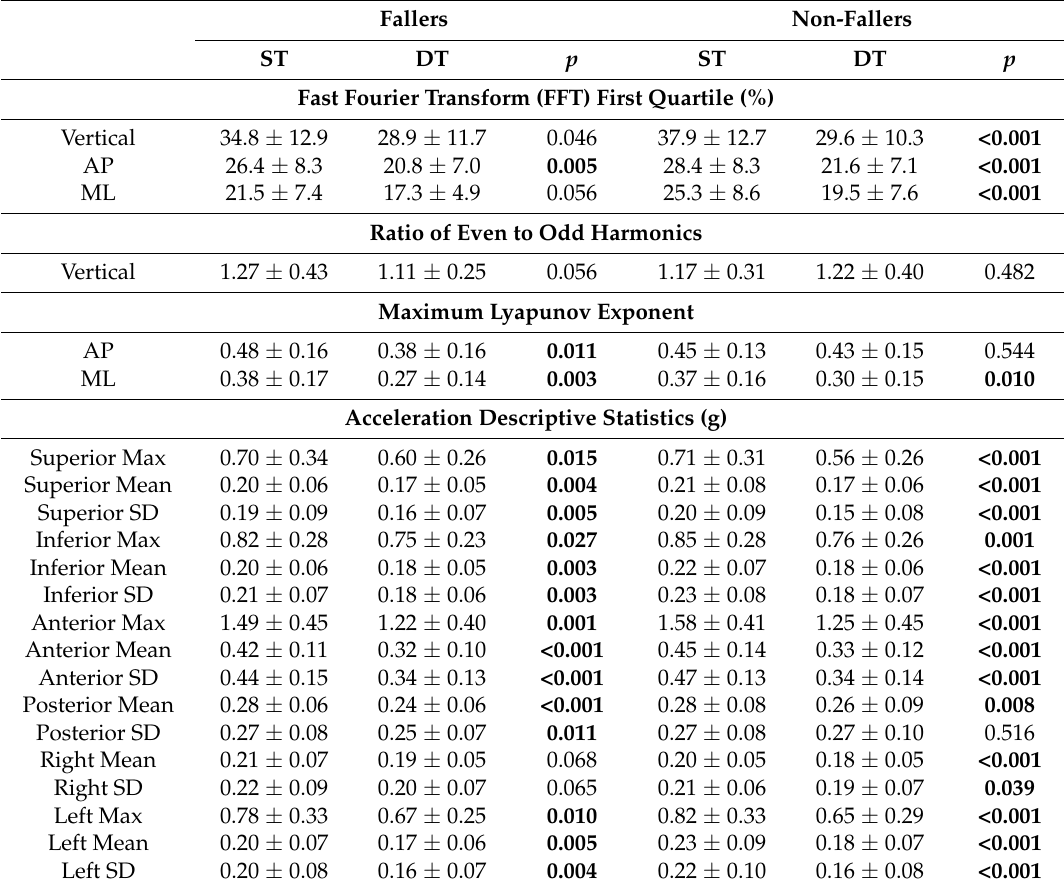
Table 5. Means and SD for left shank accelerometer variables with a significant ( p < 0.05) mixed-design ANOVA result (Supplementary Table S5). Bold p -values indicate significant differences between ST and DT conditions after correction for multiple